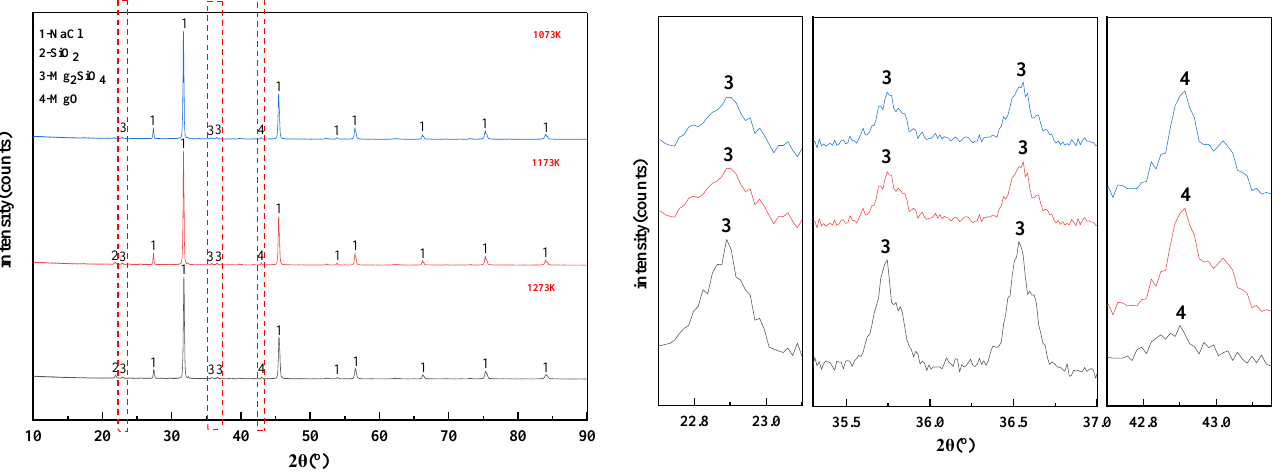
Figure 12. XRD of filter residues obtained with different temperature.